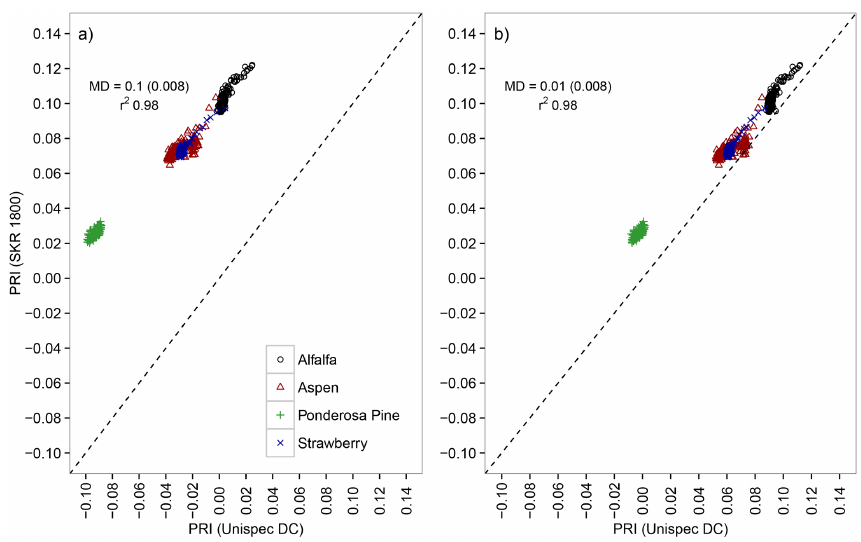
Figure 3. Scatter plots of UniSpec DC photochemical reflectance index (PRI) vs. SKR 1800 PRI across a range of plant canopies during a series of dark-to-light transitions. (a) Depicts the data without correction for differences in SRFs and (b) depicts the data after normalization for differences in the spectral configuration. The dotted lines represent the 1:1 line. MD in the plots stands for mean differences and the values in the parentheses are the standard deviation of the differences.